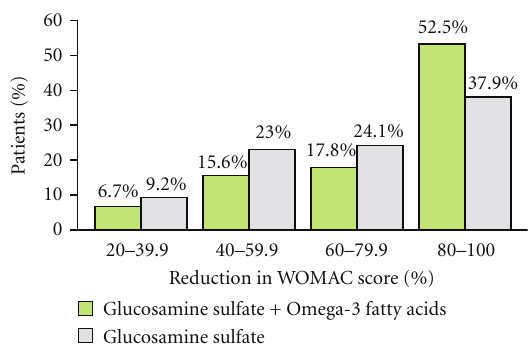
Figure 3: A greater proportion of patients with combination ther- apy GlcN · S + O-3 FA showed the highest WOMAC improvements of 80–100%